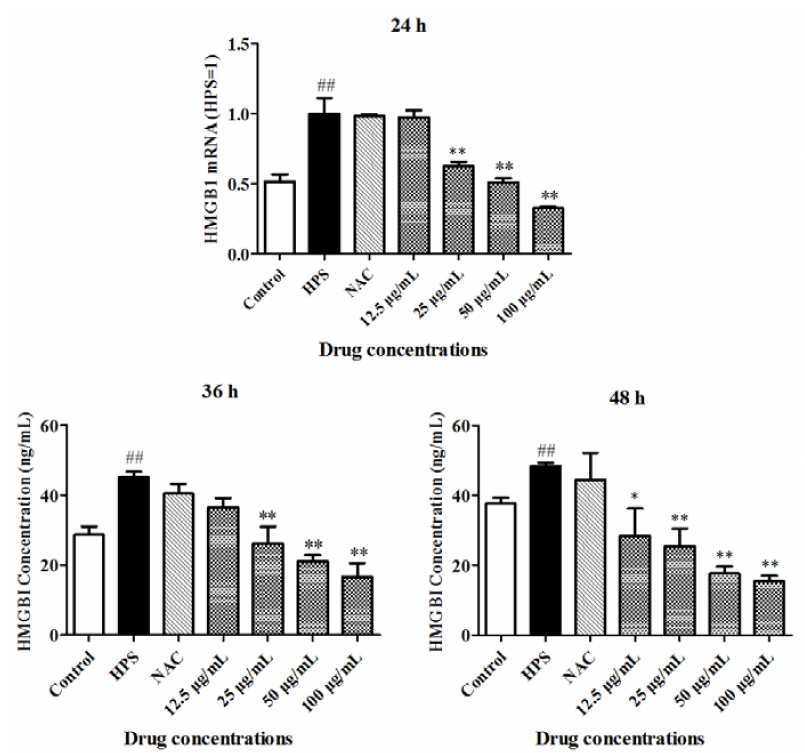
Figure 2. The effect of baicalin on HMGB1 release in piglet peripheral blood monocytes induced by H. parasuis . 1 × 10 6 piglet peripheral blood monocytes were pretreated with baicalin at 12.5, 25, 50, 100 µ g/mL or NAC (1 mM/mL) for 1 h. 1 × 10 6 CFU/mL H. parasuis were added to the wells and co-infected for 24, 36 and 48 h. The HMGB1 concentration was measured. ## p < 0.01 vs. control. * p < 0.05; ** p < 0.01; HPS: H. parasuis .